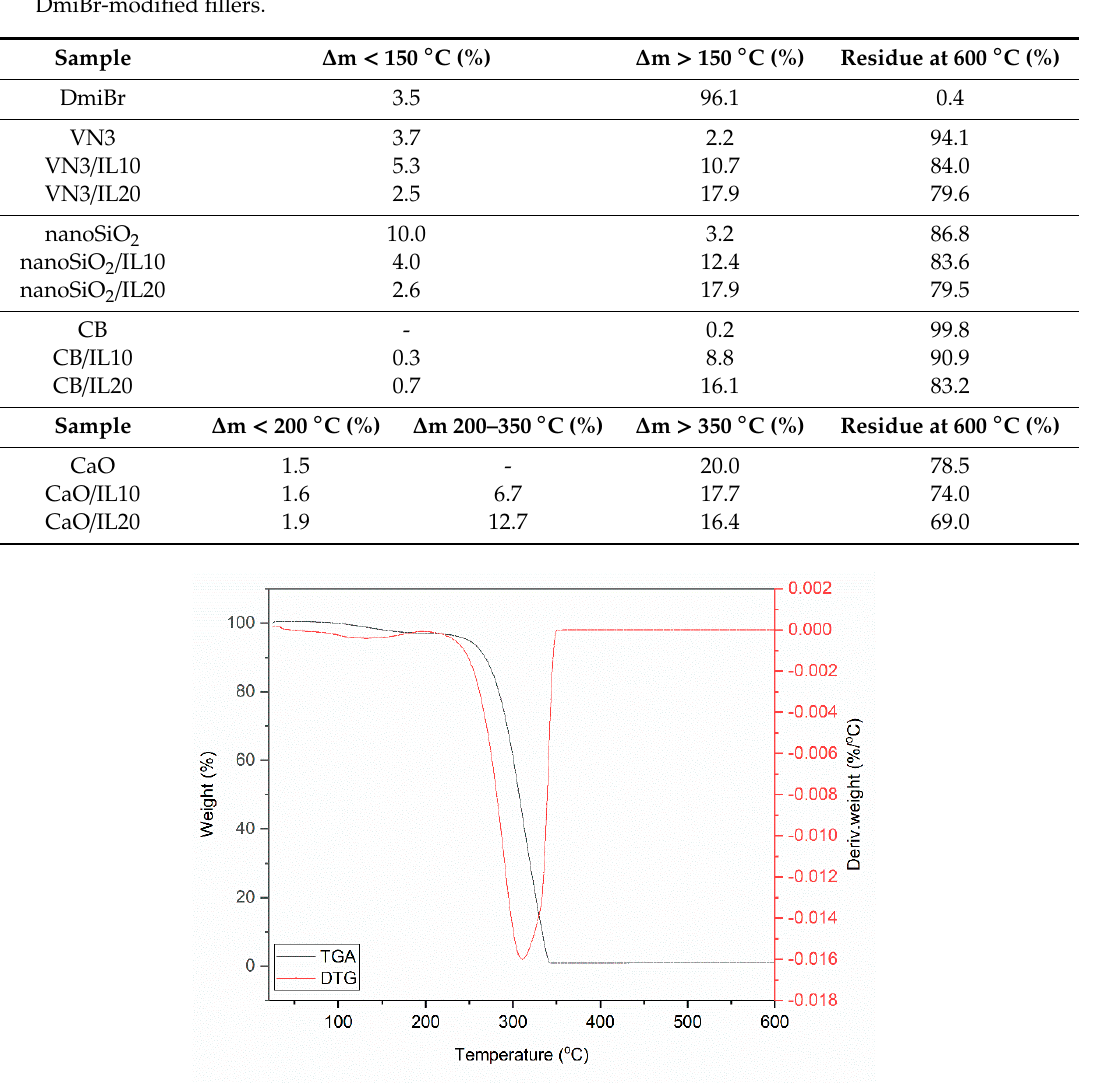
Figure 1. Thermogravimetric ( TG) curve for DmiBr.